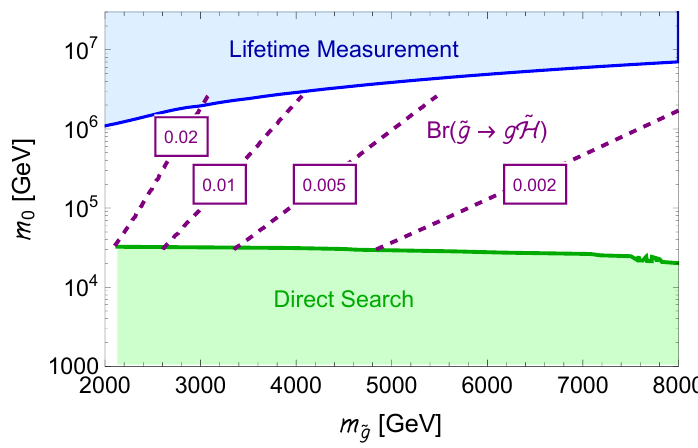
Figure 3 . The gluino-squark mass plane, categorized by means of experimentally probing the squark mass scale. At low squark masses (green region), associated squark-gluino production o(cid:11)ers direct access to valence squark masses [17]. At large squark masses (blue region), a displaced gluino vertex could be measured, as the lifetime is above 100 microns [68{70]. The intermediate region is more challenging: here the two-body gluino decay e g ! g e H , with branching ratio indicated on purple dashed contours, is logarithmically sensitive to the scalar mass scale [71]. For